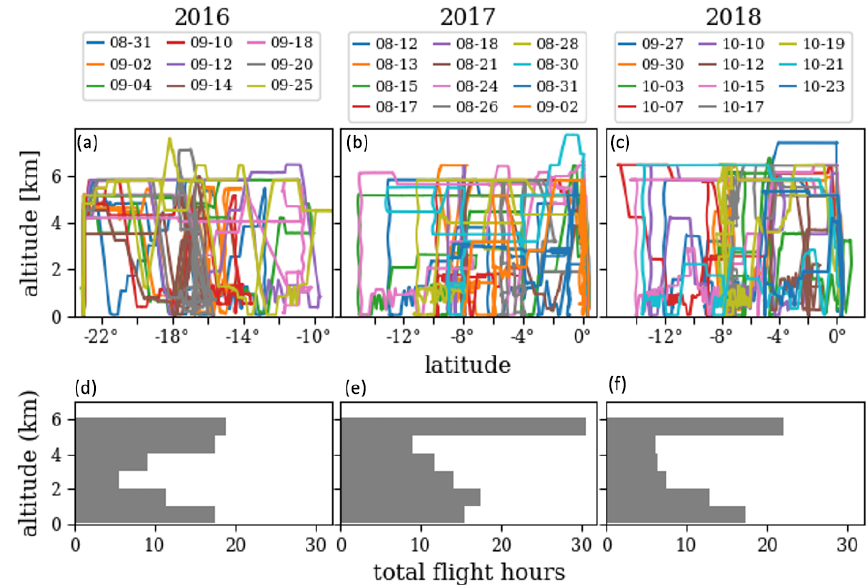
Figure 2. P-3 latitude–altitude sampling statistics for flights where WISPER took quality data. (a–c) P-3 latitude vs. altitude tracks colored by flight date (month–day). (d–e) Total flight hours at each kilometer of